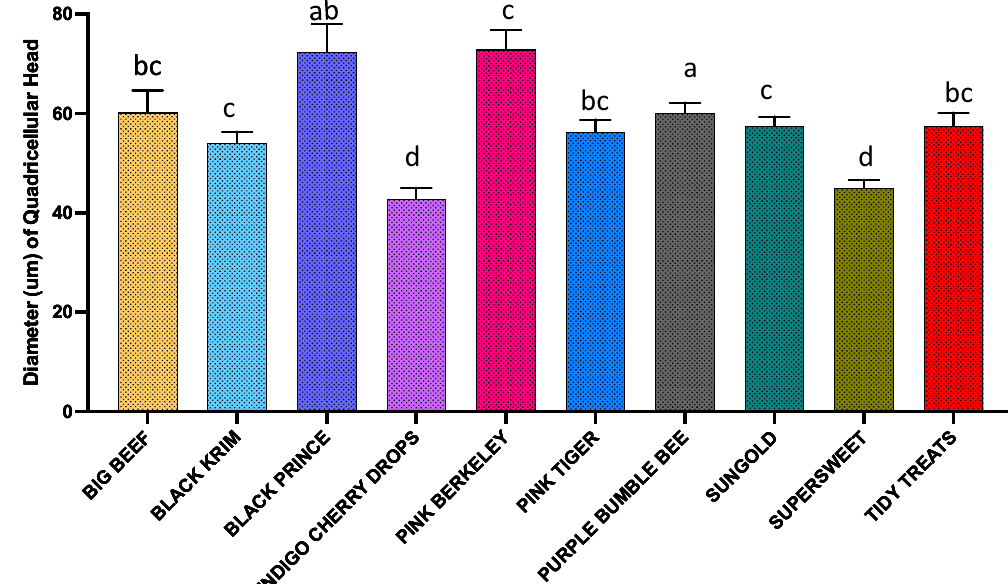
Fig. 9 Comparison of diameter (µm) of quadricellular head of glandular trichome with large quadricellular head in ten varieties of tomato